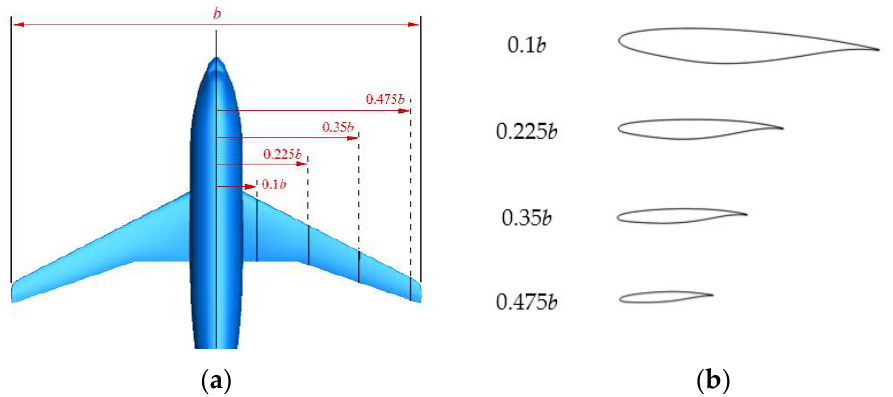
Figure 10. Spanwise locations and airfoil profiles of different sections on the wing. ( a ) Spanwise location; ( b ) section profiles.